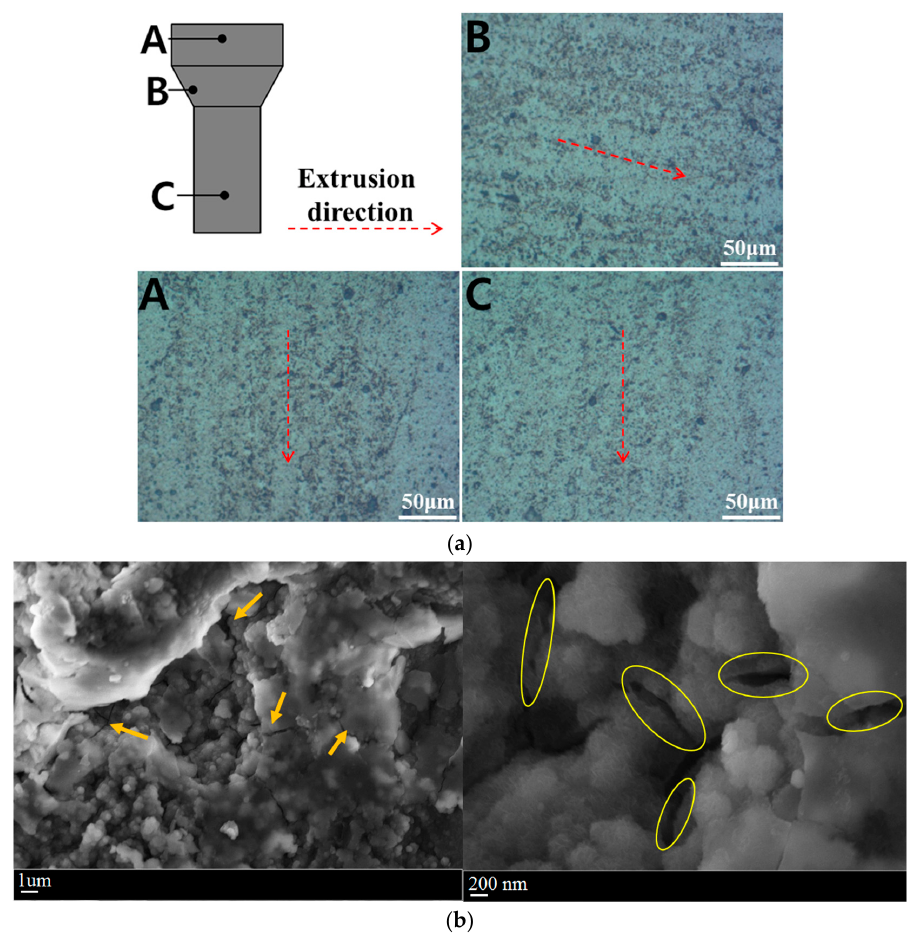
Figure 12. Microstructure of composite analysis (10 vol % CNTs/Al6061, 520 °C, R = 4): ( a ) microstructure at three positions, and ( b ) Scanning electron microscopy (SEM) of the dimple fracture. The factors causing the inability to form a 10 vol % CNTs/Al6061 composite at extrusion ratio R = 4 at 520 °C can be analyzed as follows: First, the internal combination of Al6061 (matrix) and CNTs (reinforcement) is significantly important. Second, densification chiefly determines whether powder is evenly dispersed within the billet of CNTs/Al6061 composite fabricated using the powder forming process. Friction generated in the forming process directly affects the forming. Although friction has a